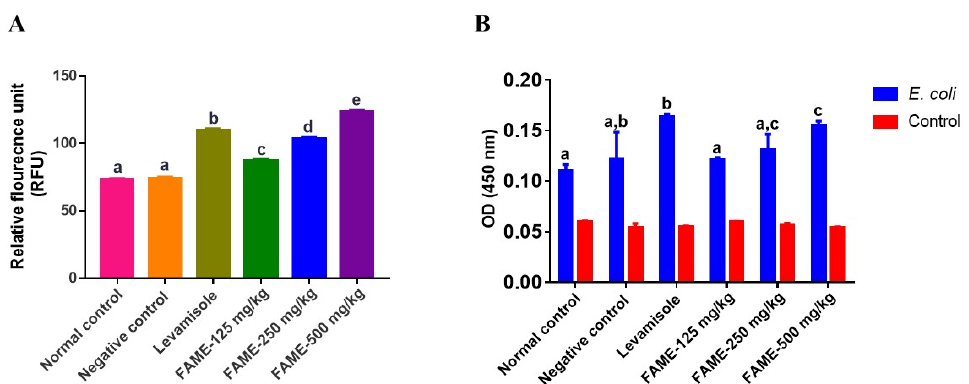
Figure 5. Effects of FAME on neutrophil migration ( A ) and phagocytic activity ( B ). Data are expressed as the mean ± SEM ( n = 3). Different letters (a–e) above the bars indicate significant differences ( p < 0.05) between groups.